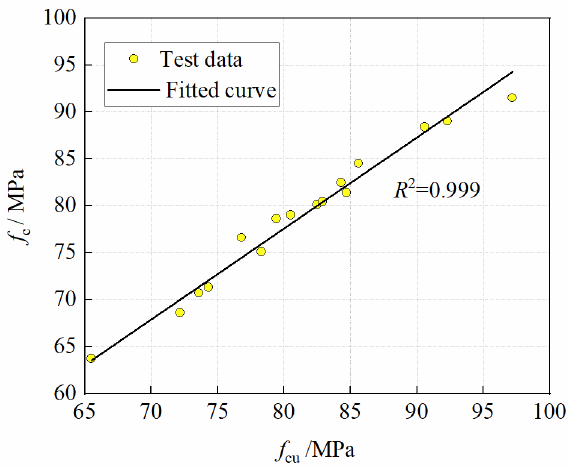
Figure 13. Relationship f c vs. f cu.